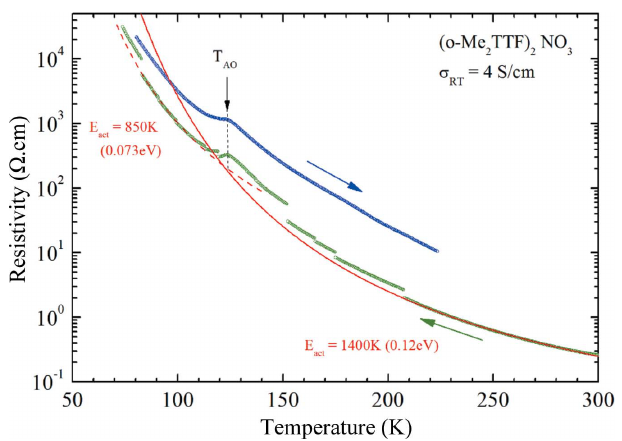
Figure 2 Temperature dependence of the longitudinal resistivity for ( o -Me 2 TTF) 2 NO 3 . The red solid (dashed) curve is the fit to the high- temperature (low-temperature) data with (cid:8) = (cid:8) 0 exp( E act / T ). The higher resistivity observed in the warming cycle is attributed to cracks affecting the crystal during the initial cooling process.